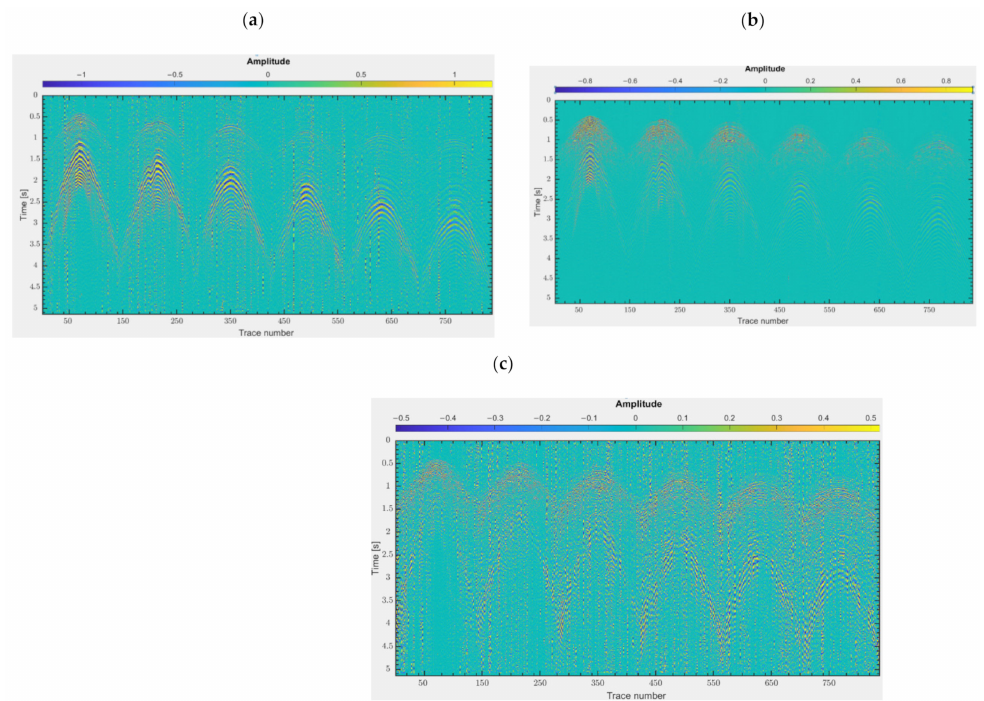
Figure 3. Shot gathers of the closest shot to the VSP well (112 m from the wellhead) recorded by ( a ) hydrophones, ( b ) geophones deployed over six receiver lines during the 3D OBC survey, as shown in Figure 5 and ( c ) summation of hydrophones and geophones.